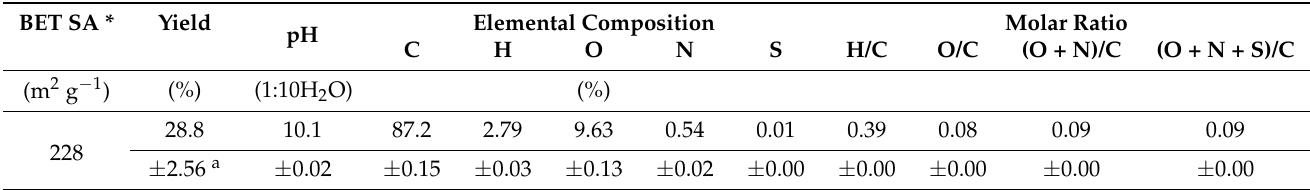
Table 1. Biochar characteristics used in this